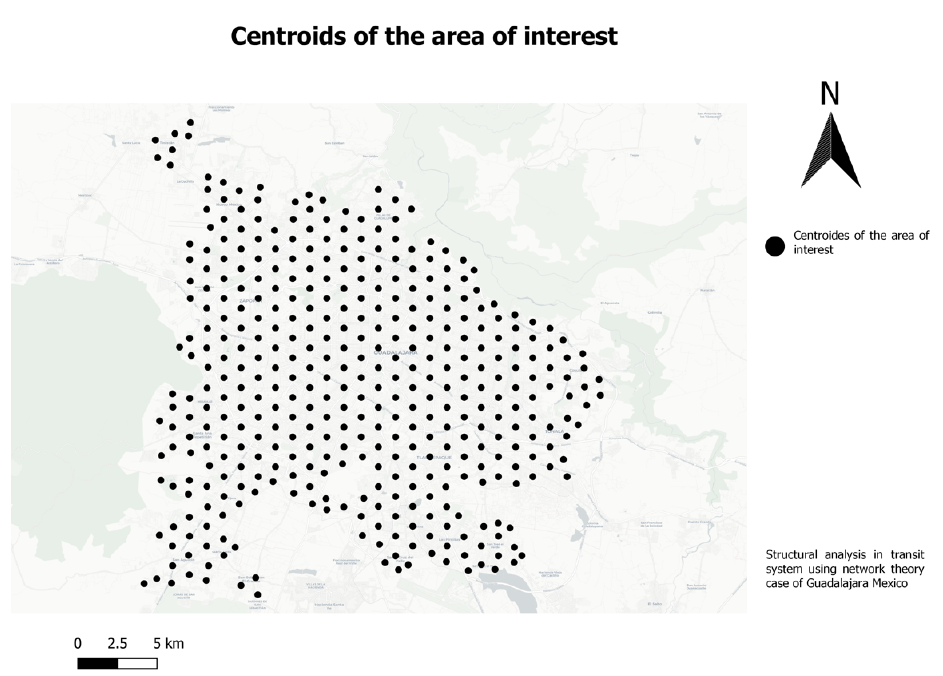
Figure 4. Centroids of the area of